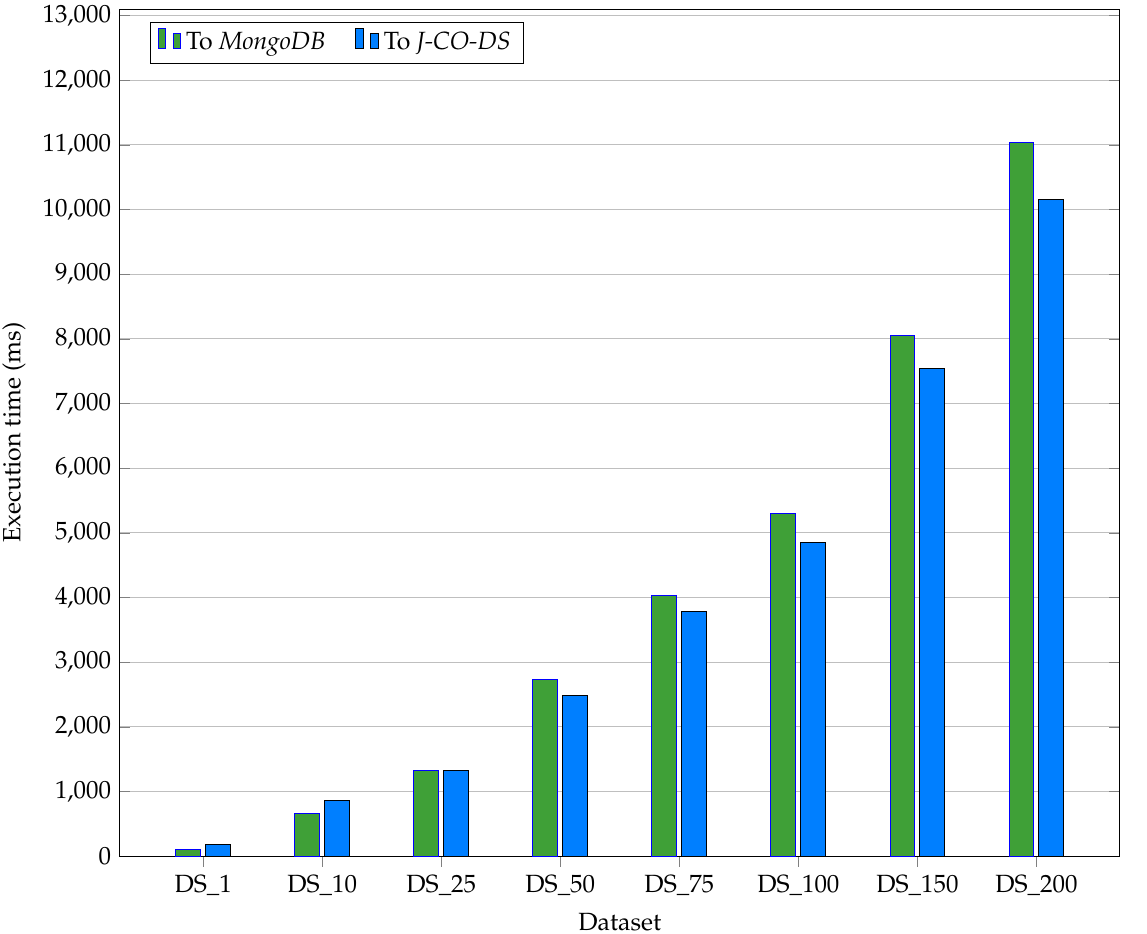
Figure 10. Performance comparison between MongoDB and J-CO-DS (for saving